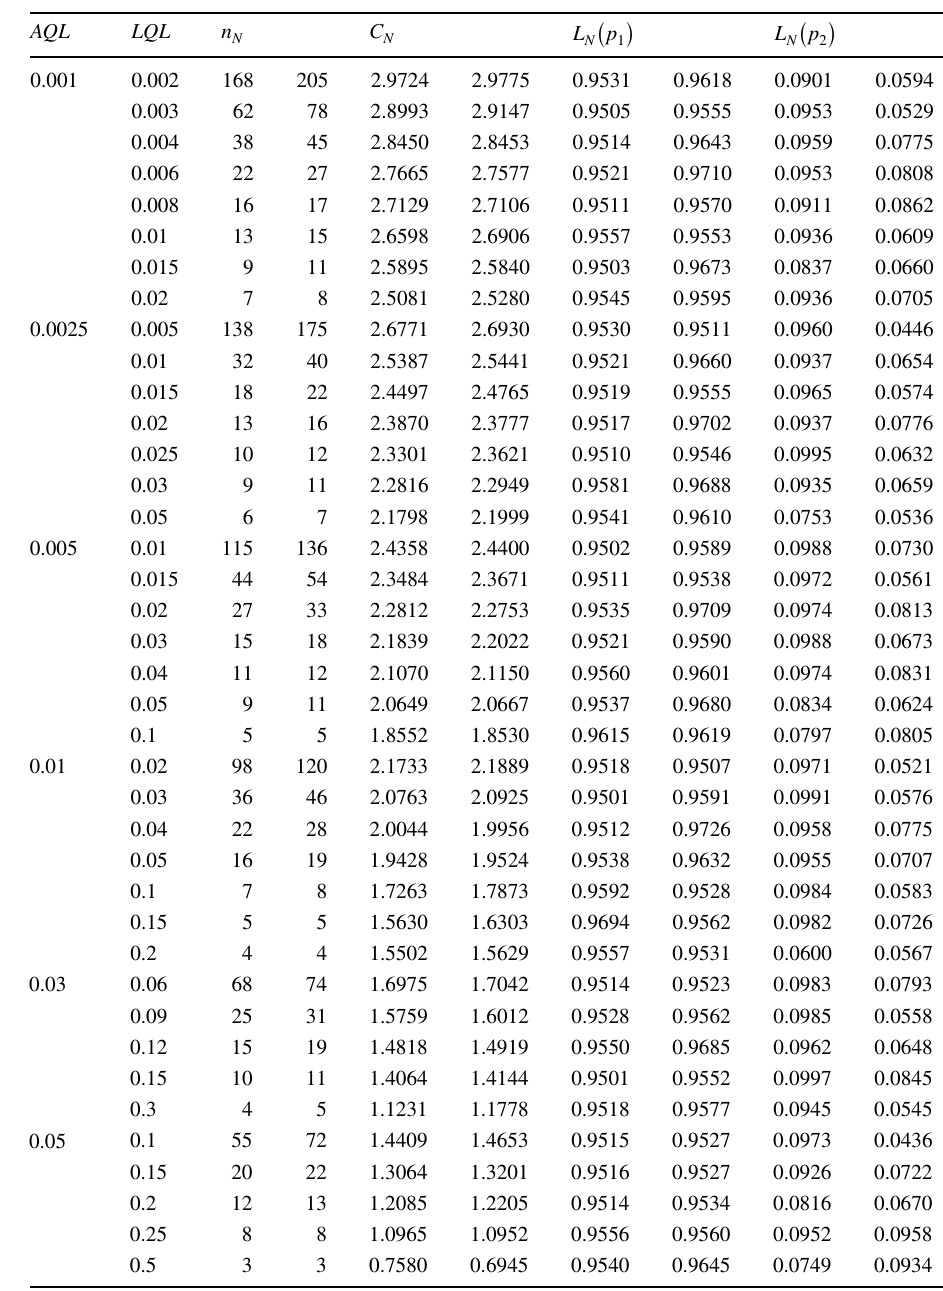
Table 3 Plan parameters for proposed plan, when 𝜎 Y N is = known and 𝜌 X N Y N